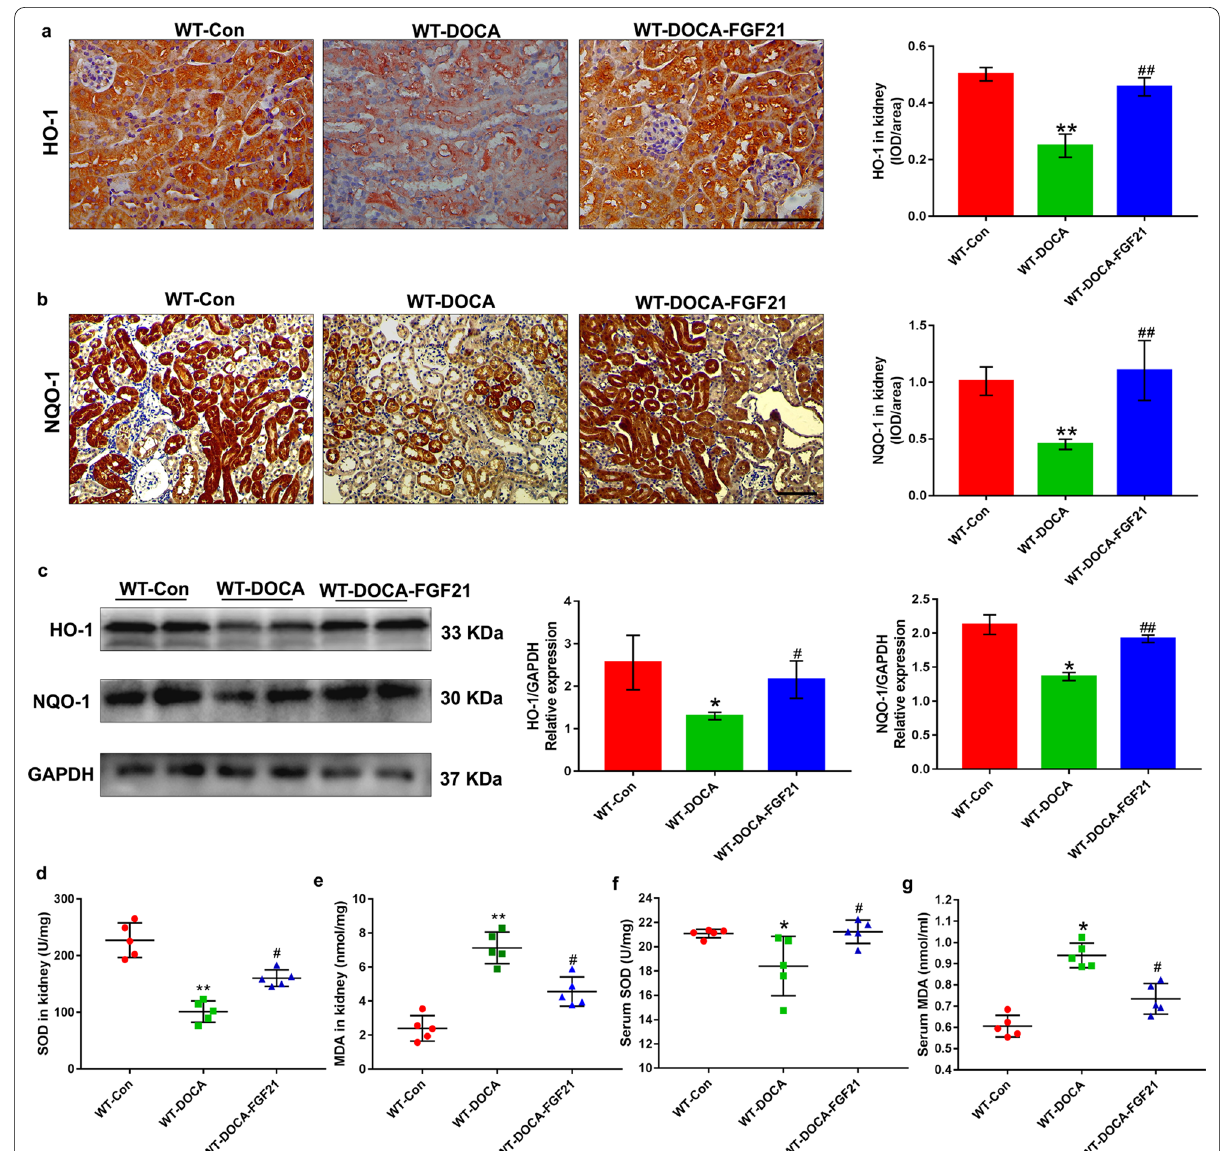
Fig. 5 rhFGF21 improves the impaired antioxidant activities of kidney in mice treated with DOCA‑salt. Eight‑week‑old male FGF21 WT mice were randomly divided into three experimental groups: the WT‑Control group treated with sham operation, followed by intraperitoneal injection with 0.9% normal saline; the WT‑DOCA group treated with DOCA‑salt; the WT‑DOCA‑FGF21 group treated with DOCA‑salt, followed by intraperitoneal supplementation of recombinant human FGF21 (rhFGF21, 500 μg/kg/day body weight). Serum and kidney tissues were harvested at 8 days after intervention. a and b Kidney sections were collected and stained with antibody against HO‑1 and NQO‑1 and the quantitative mean integrated optical density (IOD)/area of HO‑1 and NQO‑1 were analyzed by Image‑Pro plus 6.0 in each group were shown. c Protein expressions of HO‑1 and NQO‑1 were determined by Western blot. GAPDH was used as loading and normalization control and the quantifications of protein expressions of HO‑1 and NQO‑1 were analyzed by Image J. d and e Effects of rhFGF21 on malonyldialdehyde (MDA) and superoxide dismutase (SOD) levels of kidney tissues at 8 days after DOCA‑salt treatment. f and g Serum levels of MDA and SOD were measured at 8d after DOCA‑salt treatment in each group. Data are presented as Mean SD, n 5–6 mice/group. *P < 0.05, **P < 0.01 versus the WT control group; # P < 0.05, ## P < 0.01 versus the ± = WT‑DOCA group. Scale bar: 100